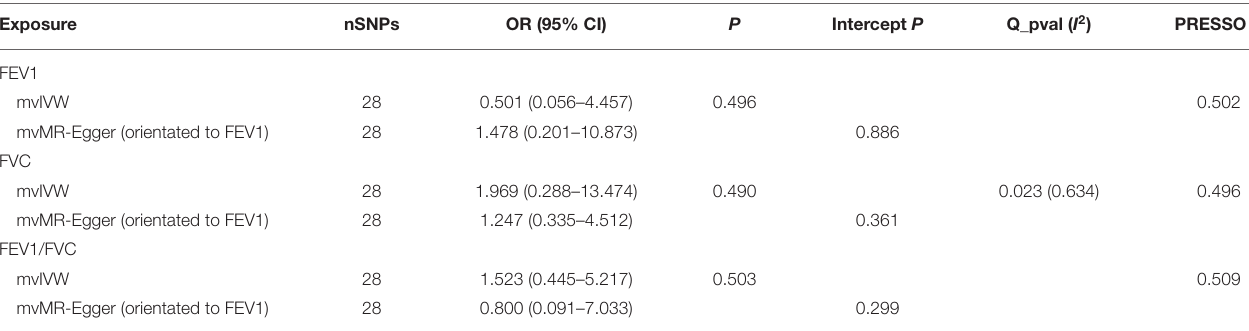
TABLE 5 | Multivariable MR analyses for lung function and AF.